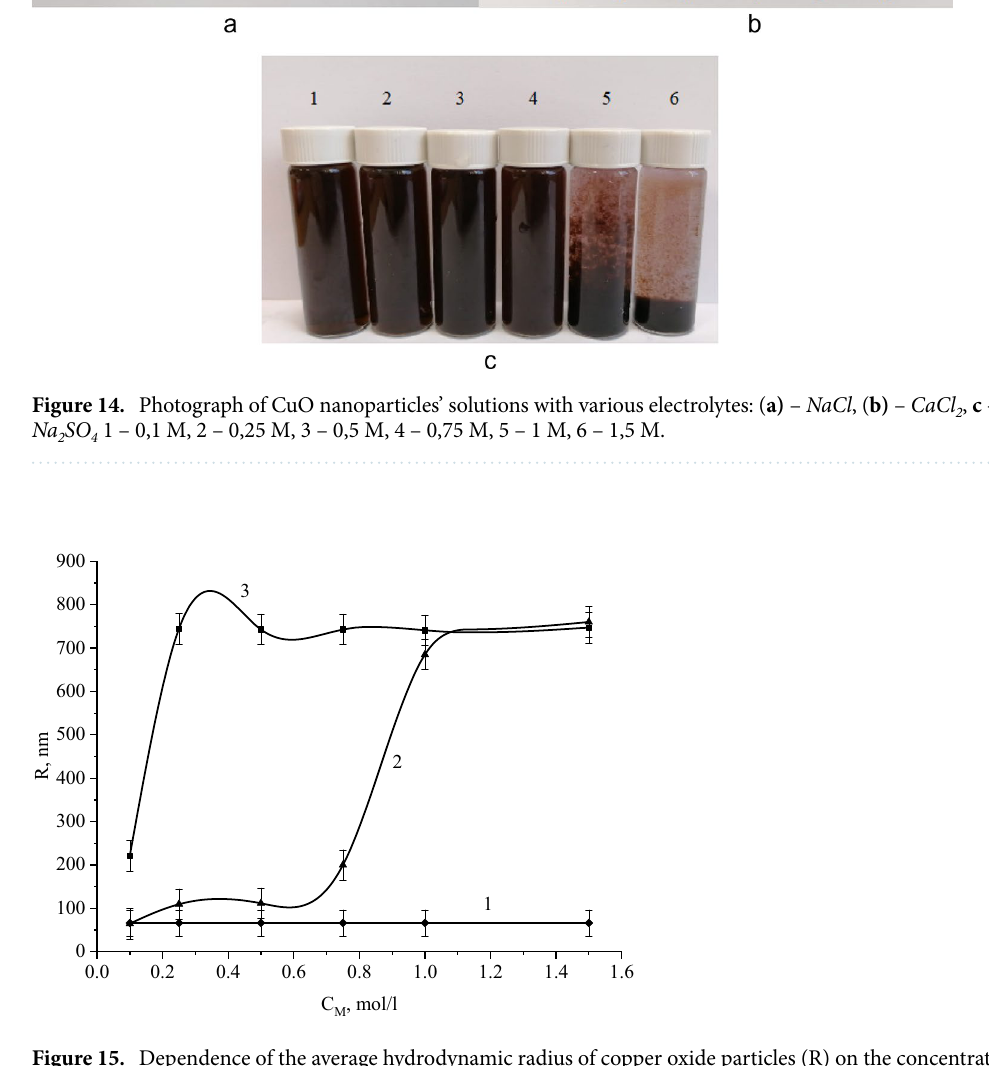
Figure 15. Dependence of the average hydrodynamic radius of copper oxide particles (R) on the concentration of electrolytes: 1 – NaCl , 2 – Na 2 SO 4 , 3 – CaCl 2